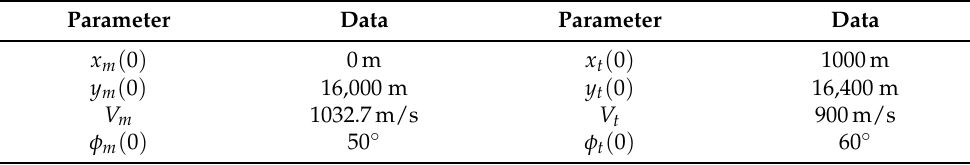
Table 5. Some constants and initial conditions for the missile and the target in the simulations with different terminal LOS